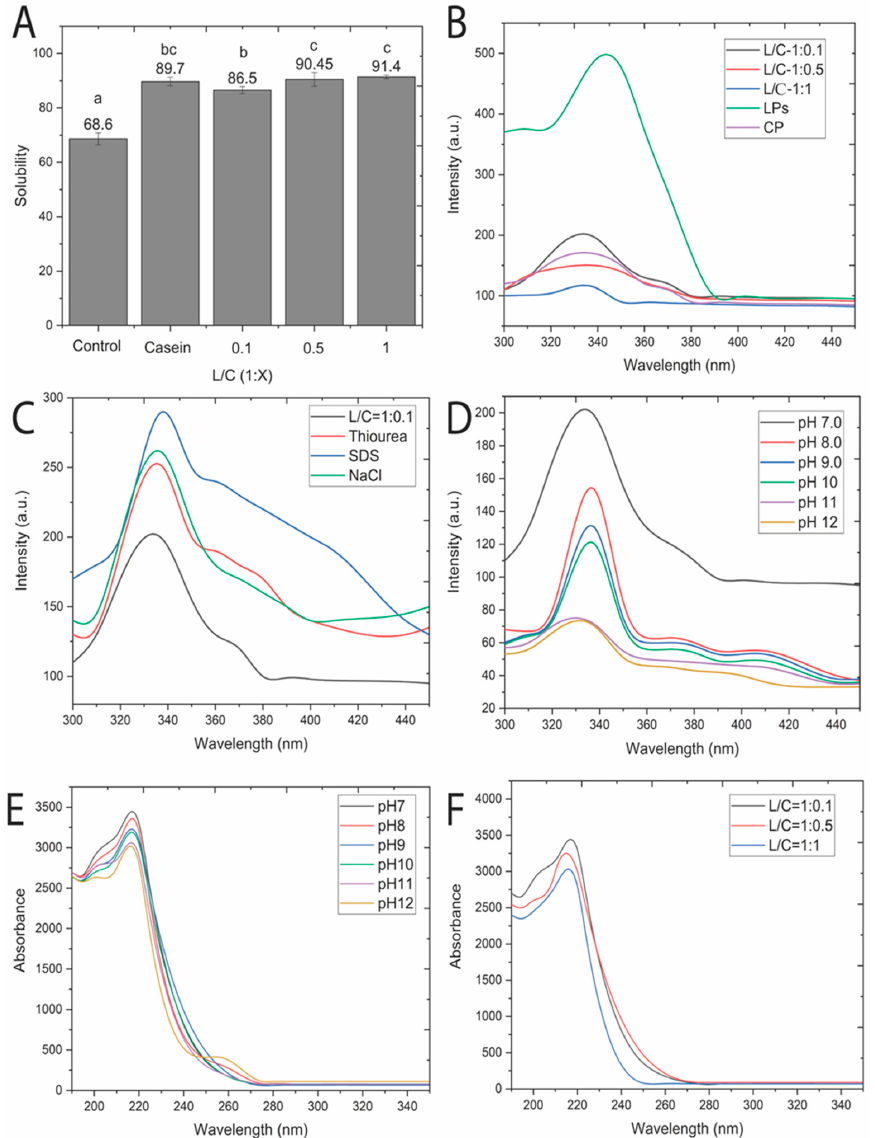
Figure 2. Spectroscopic analysis of structural interactions. ( A ) Evaluation of the nitrogen solubility index of lentil proteins (LP) and lentil–casein protein complexes (LCPC) with various proportions. ( B ) Fluorescence absorption of LP with various LP to casein proteins (CP) at pH 7. The small picture represents the absorption spectra of LCPC with various LP:CP ratios at pH 7. ( C ) Fluorescence intensity spectrum of LCPC at a ratio of 1.0:0.1 (LCPC 1.0:0.1) at various pH levels (pH 7 to 12). ( D ) Fluorescence intensity spectrum of LCPC 1.0:0.1 in the presence of foreign compounds. ( E ) The ultraviolet-visible wavelength description of LCPC 1.0:0.1 at pH levels ranging from 7 to 12. ( F ) Pro- files of the ultraviolet-visible spectra of LCPC 1.0:0.1 at pH 7. Bars with different letters differ significantly ( p <